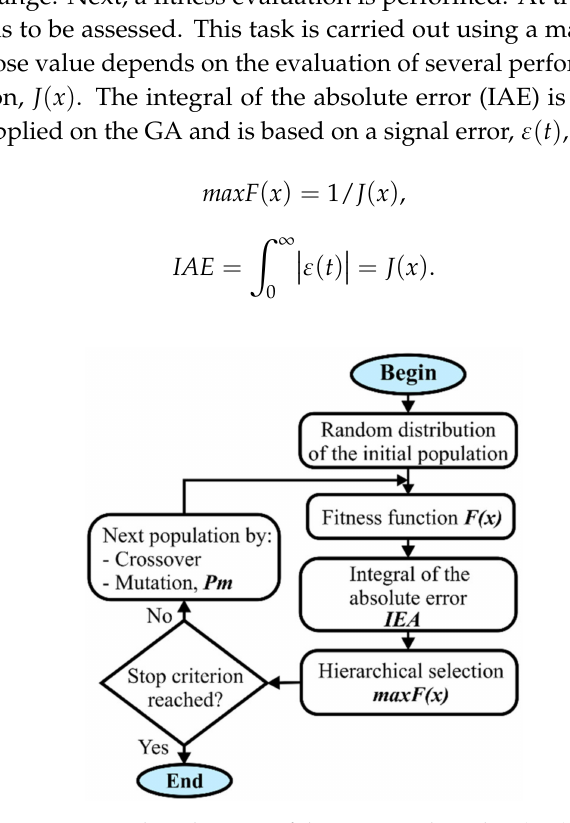
Figure 1. Flow diagram of the Genetic algorithm